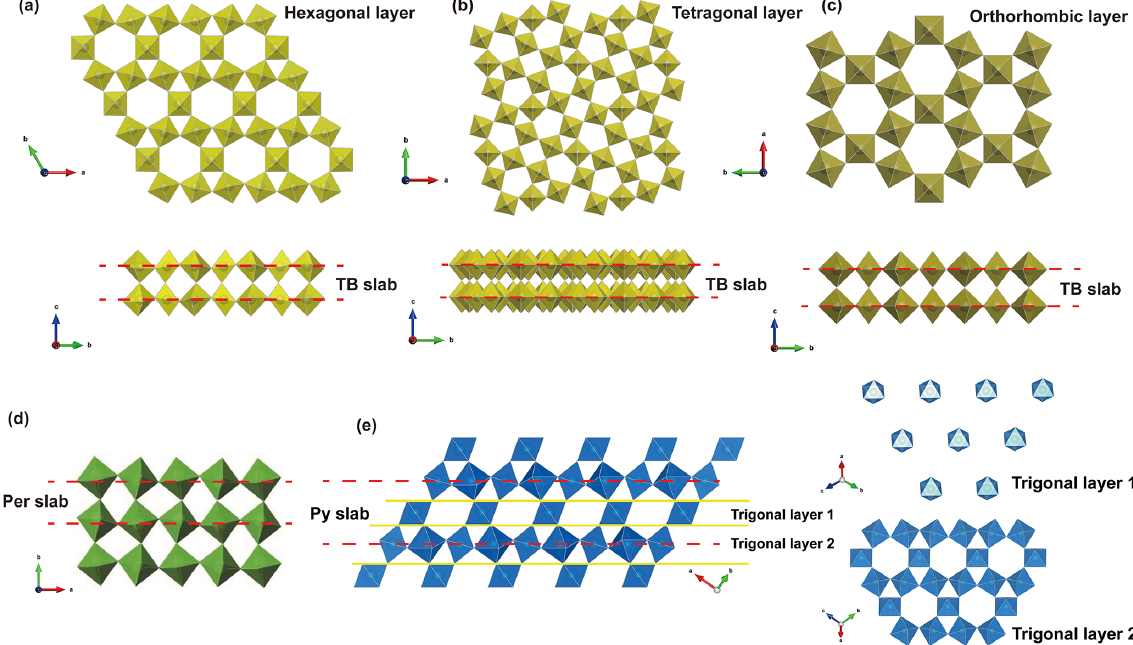
Figure 13. [WO 6 ] octahedra framework for tungsten-bronze-type, perovskite-type, and pyrochlore-type structures. (a) Hexagonal tung- sten bronze (HTB), (b) tetragonal tungsten bronze (TTB), (c) orthorhombic tungsten bronze (OTB), (d) perovskite-type structure (Per), (e) pyrochlore-type structure (Py). Pyrochlore slab is denoted by Py, while TB and perovskite slabs are indicated by TB and Per, respectively. A and Y sites are omitted for